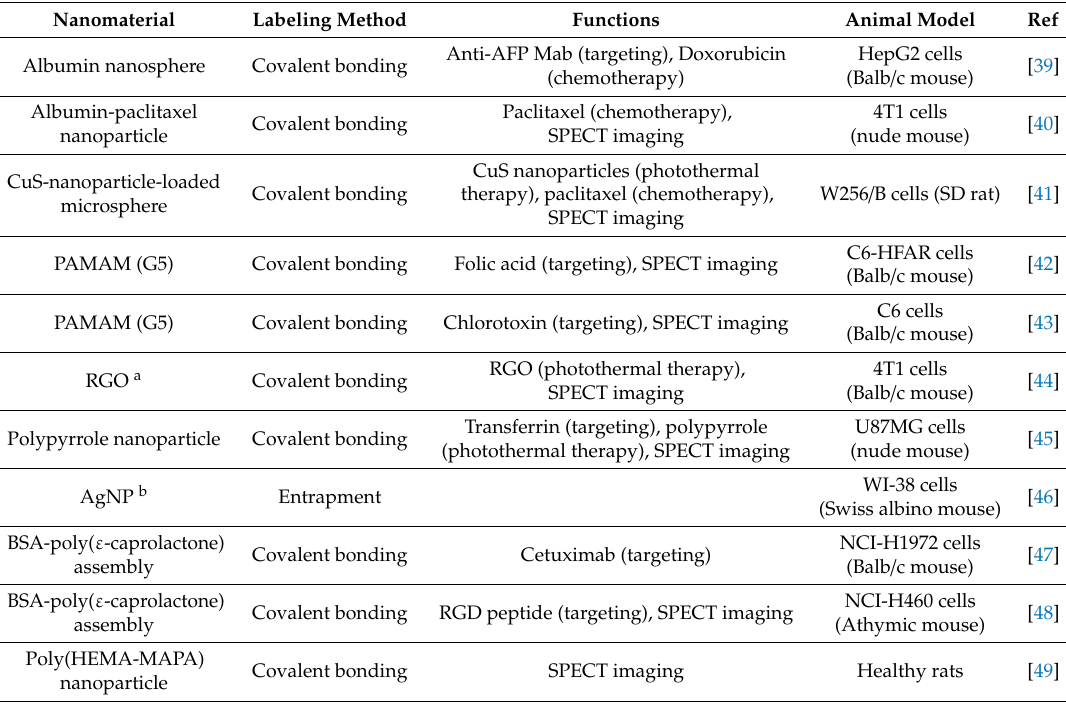
Table 2. 131 I-labeled functional